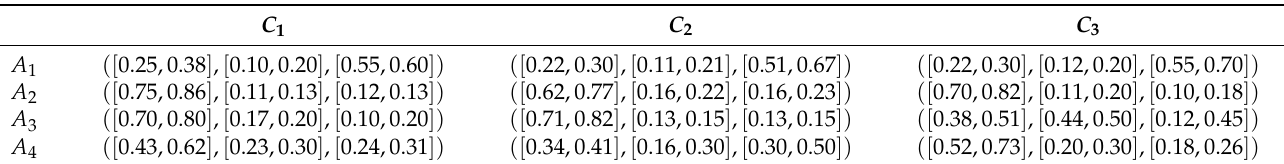
Table 1. The criteria of clients in Example 3.